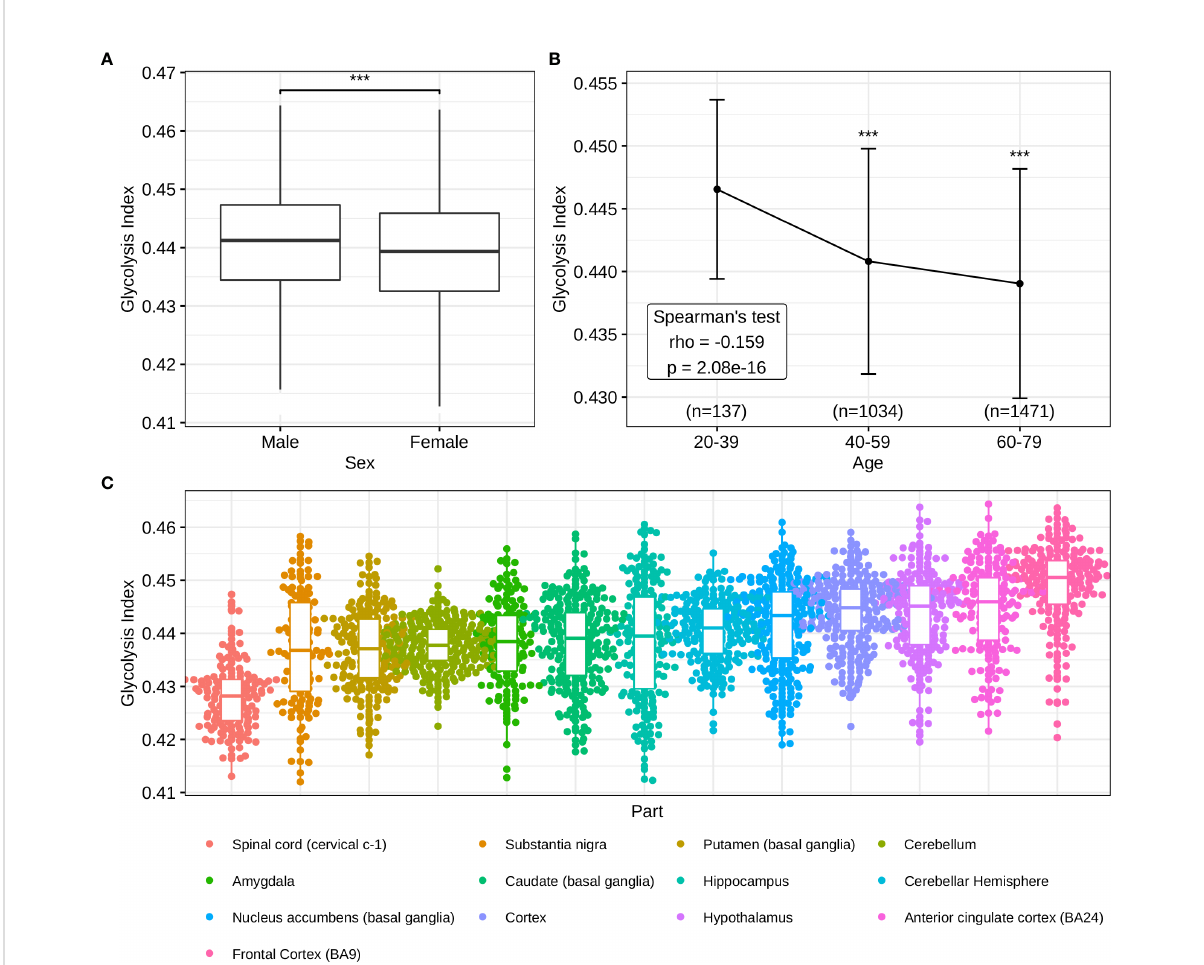
FIGURE 6 Distributions of glycolysis indices in normal brain tissues (A) The sex difference of glycolysis indices. (B) Glycolysis indices in different age groups. (C) Distributions of glycolysis indices in the different parts of the brain.